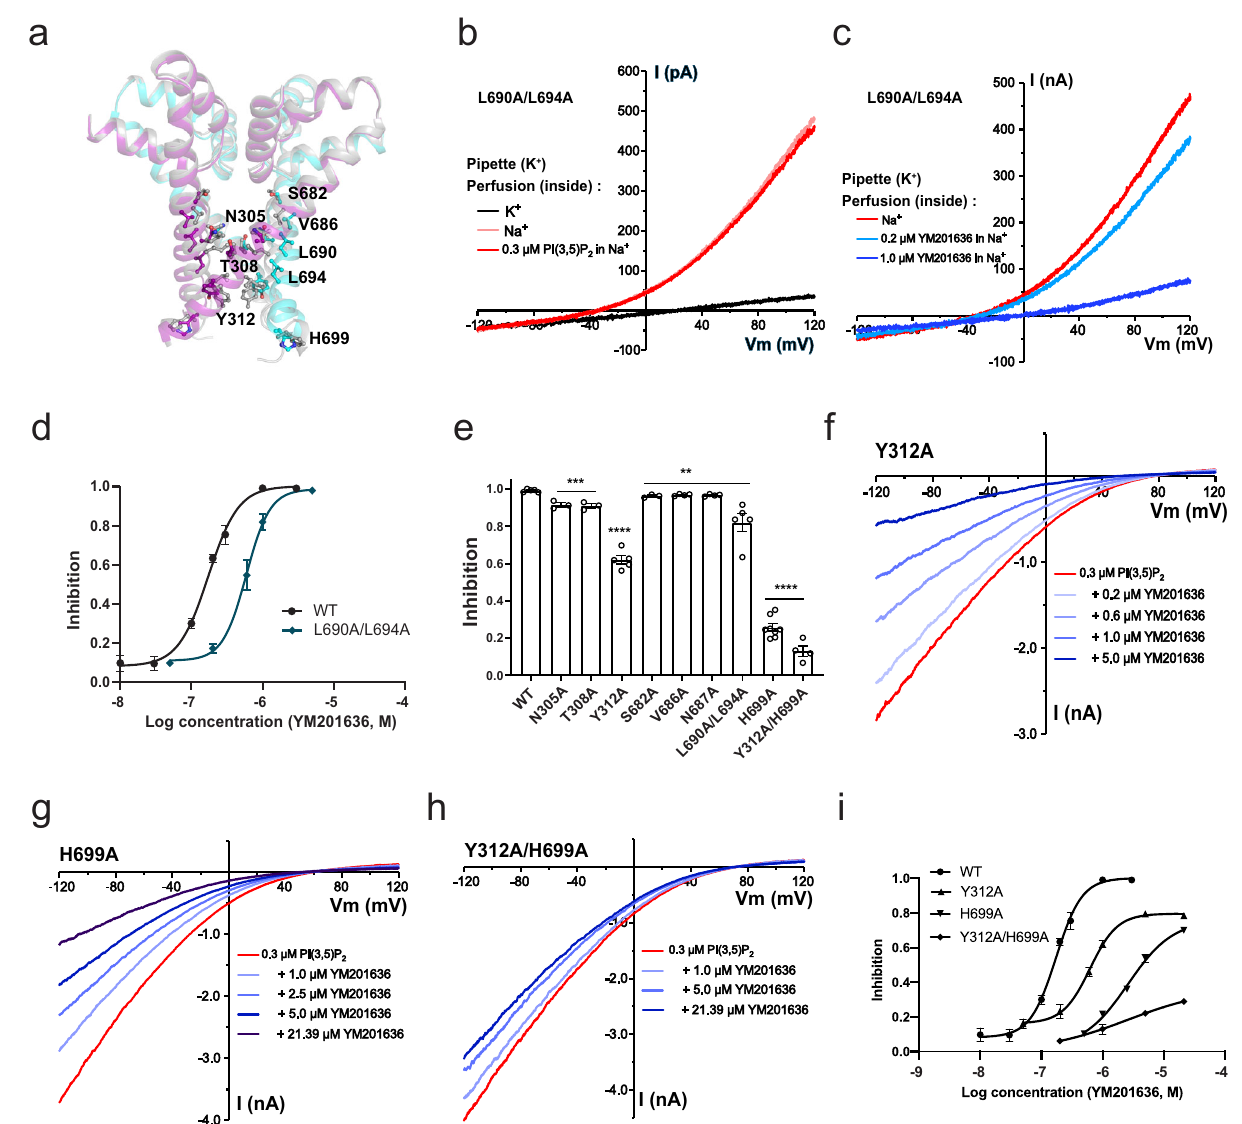
Fig. 4 The effects of YM201636 on human TPC2 pore region mutants. a Pore region structures of the PI(3,5)P 2 -bound open-state (colored) (PDB ID: 6NQ0) and apo/closed-state (gray) (PDB ID: 6QN1) human TPC2 channels showing the positions of the mutated residues in this study. b The constitutively-open TPC2 PM currents induced by the L690A/L694A double mutation in the absence and presence of PI(3,5)P 2 . c The inhibition of the constitutively-open TPC2 PM/L690A/L694A channel currents by YM201636. d The dose-response of YM201636 ’ s inhibition on the constitutively-open TPC2 PM/L690A/L694A channel currents ( n = 4 – 6) as compared to that of the WT channels. e The averaged inhibitory effects of 1.0 μ M YM201636 on TPC2 PM pore-region mutant channels. The channels were activated by 0.3 μ M PI(3,5)P 2 . f – h The inhibitory effects of YM201636 on human TPC2 PM mutants Y312A ( f ), H699A ( g ), and Y312A/H699A ( h ). i Dose-responses ( n = 4 – 6 for each data point) of the YM201636 ’ s inhibitory effect on TPC2 PM mutants Y312A, H699A, Y312A/H699A as compared to that of the WT channels. All recordings were done in inside-out con fi guration using asymmetric Na + (inside)/K + (outside) ( b – c ) or Na + (outside)/K + (inside) ( e – h ) recording solutions. The averaged data are presented as mean value ± SEM. Unpaired Student ’ s t -test (two tailed) was used to calculate p values. ****, ***, ** are for p values ≤ 0.0001, ≤ 0.001, and ≤ 0.01,